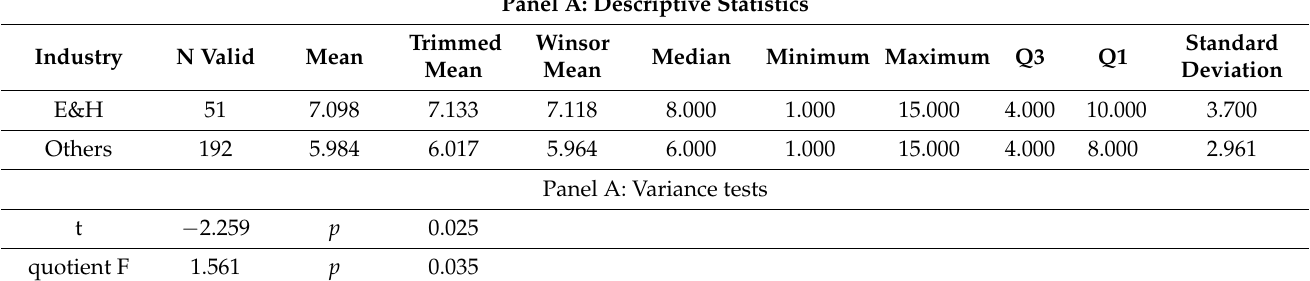
Table 12. Budget